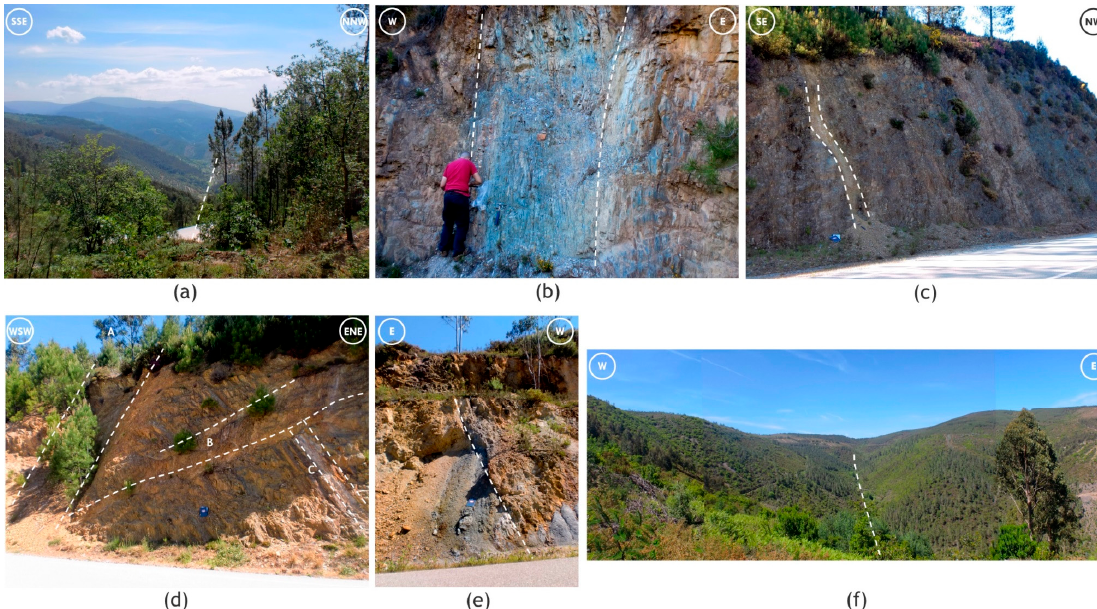
Figure 11. Examples of geological structures or general trends identified in the field that were mapped as lineaments in the preliminary interpretations: ( a ) rectilinear N 60° E valley seen from Nossa Senhora da Guia; ( b ) N 60° W near-vertical fault, west of Cadafaz; ( c ) highly fractured zone related to a N 40° E trending fault near Cabeçadas; ( d ) structures found near Cabeçadas: A—N 25° W trending fault core, B—N 60–70° W trending shear zone, C—N–S trending shear zone; ( e ) N 10° E trending fault, oblique to the Cebola fault; ( f ) N–S rectilinear valley in Vale Pião.